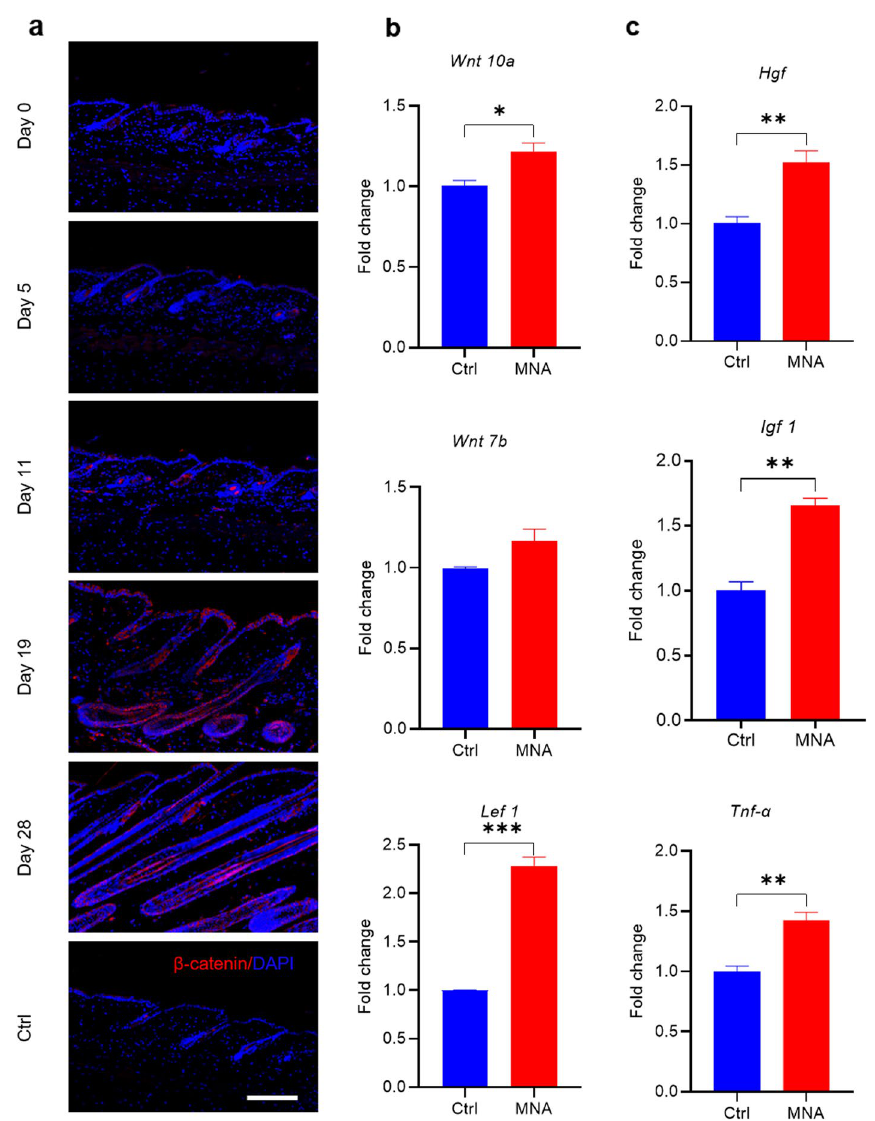
Fig. 8 MNA-induced activation of the Wnt/β-catenin signaling pathway and the upregulation of related cytokines. a Immunofluorescence staining against β-catenin showed that MNA treatment increased the expression of β-catenin in hair follicles. (Scale bar: 100 μm). b RT-qPCR results showed the increased expression levels of Wnt 10a and Lef 1 in the MNA group. * P < 0.05, ** P < 0.01, *** P < 0.001, n expression of Hgf , Igf 1 and Tnf-α in the MNA group. * P < 0.05, ** P < 0.01, *** P < 0.001, n